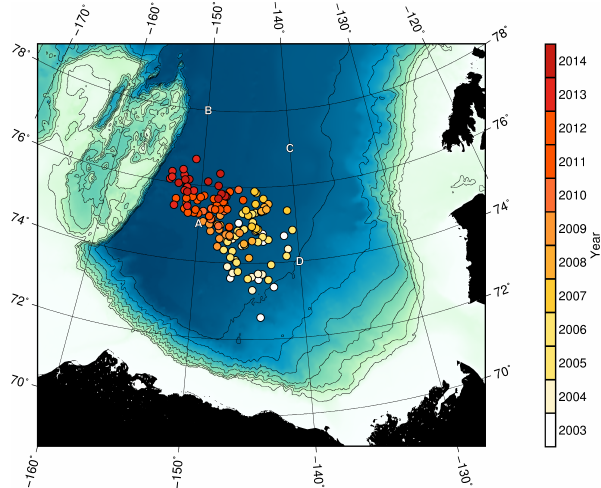
Figure 5. The monthly Beaufort Gyre centroid location estimated from the DOT. Depth contours are drawn at 1km intervals, taken from the ETOPO1 global bathymetry model (Amante and Eakins, 2009). The Beaufort Gyre Exploration Project mooring locations are shown in